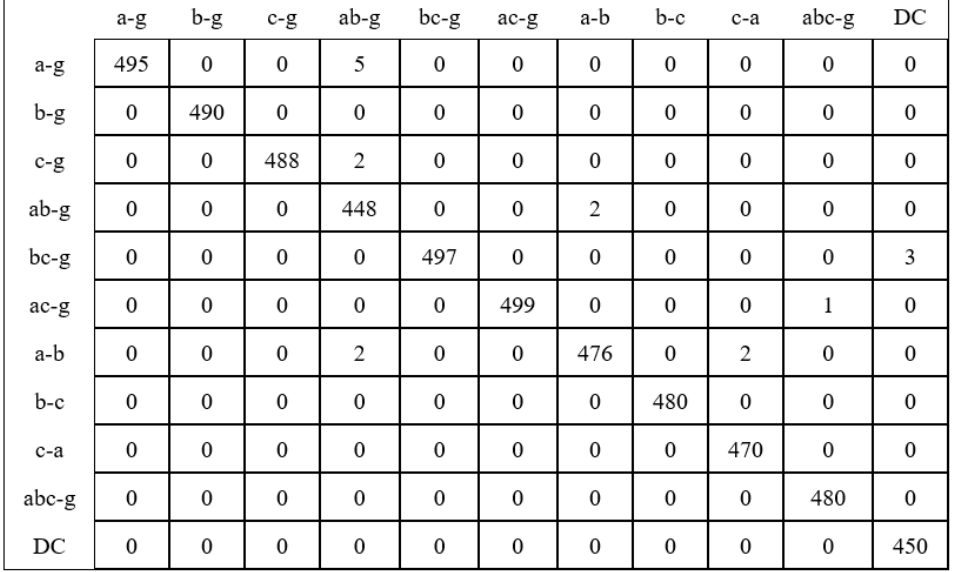
Table 2. Accuracy (%), Precision (%), sensitivity (%), and F1-Score results.